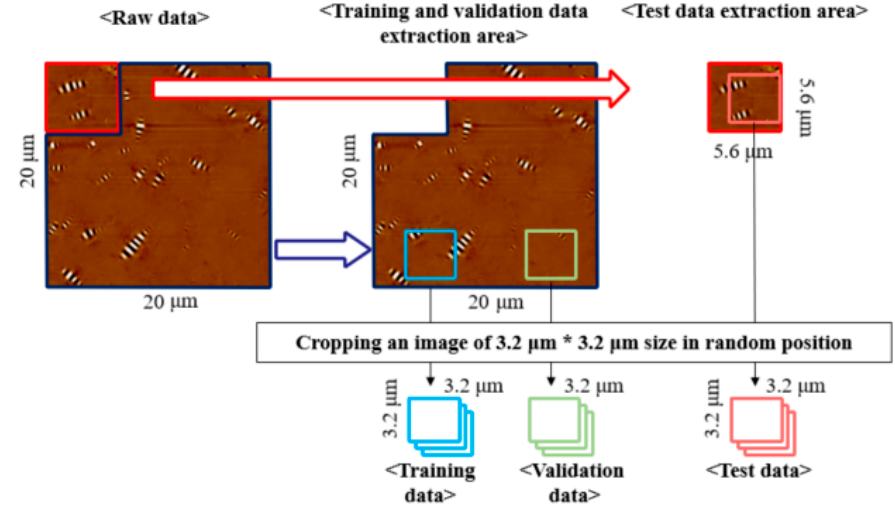
Figure 7. Image cropping process.